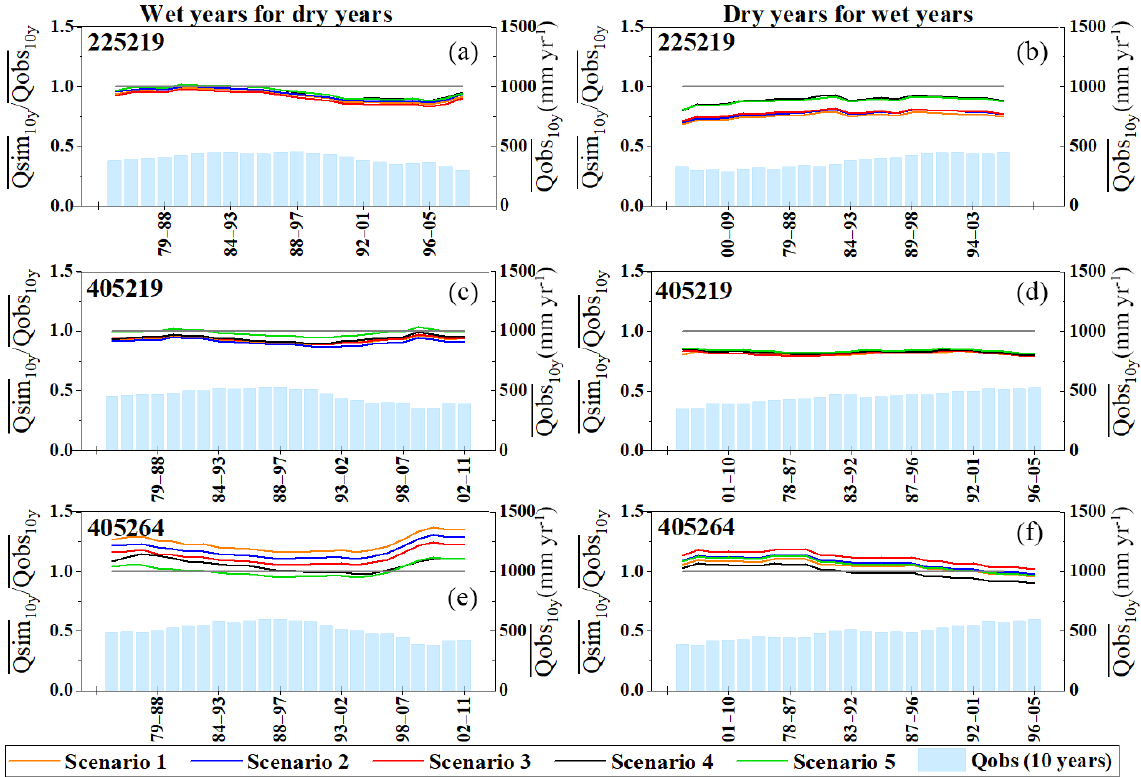
Figure 7. Long-term simulation BIAS of Q median for five scenarios in all catchments. Simulation BIAS is plotted as a 10-year moving average, and 10-year moving average streamflows are plotted for reference. The three left-hand graphs are calibrated in the wet years and then verified in the dry years, while the opposite sequence applies to the right-hand graphs.